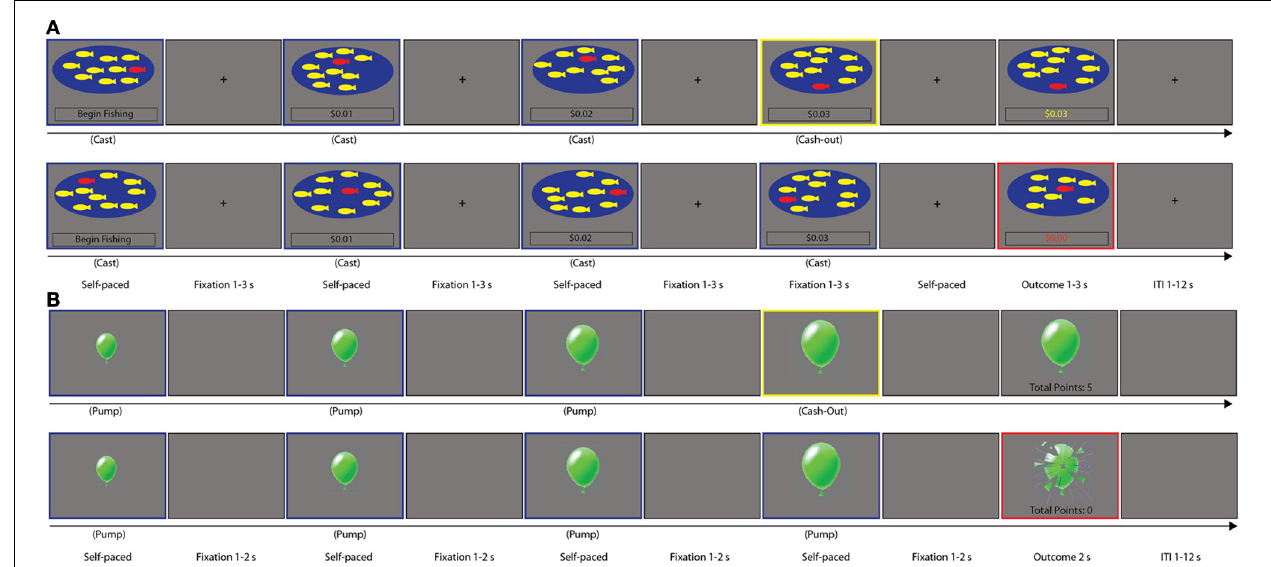
FIGURE 1 | Task Schematic of the (A) Angling Risk Task (ART) and (B) Balloon Analog Risk Taking task (BART). For both tasks, Risky choice trials are enclosed in blue, Cash-out trials are enclosed in yellow,